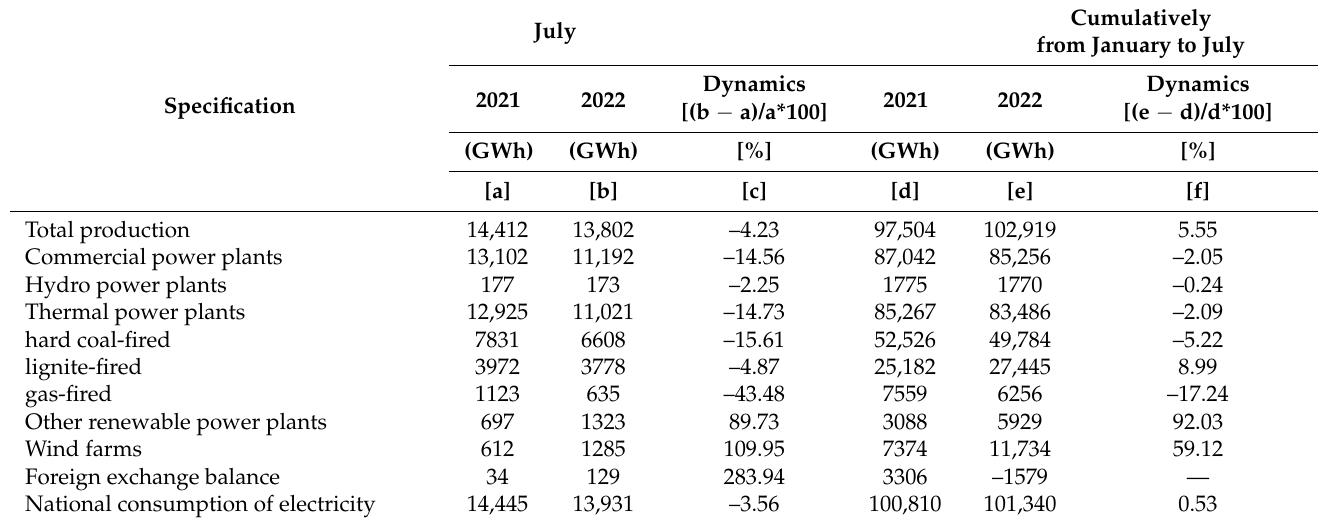
Table 2. Electricity production by source type in July, 2022.